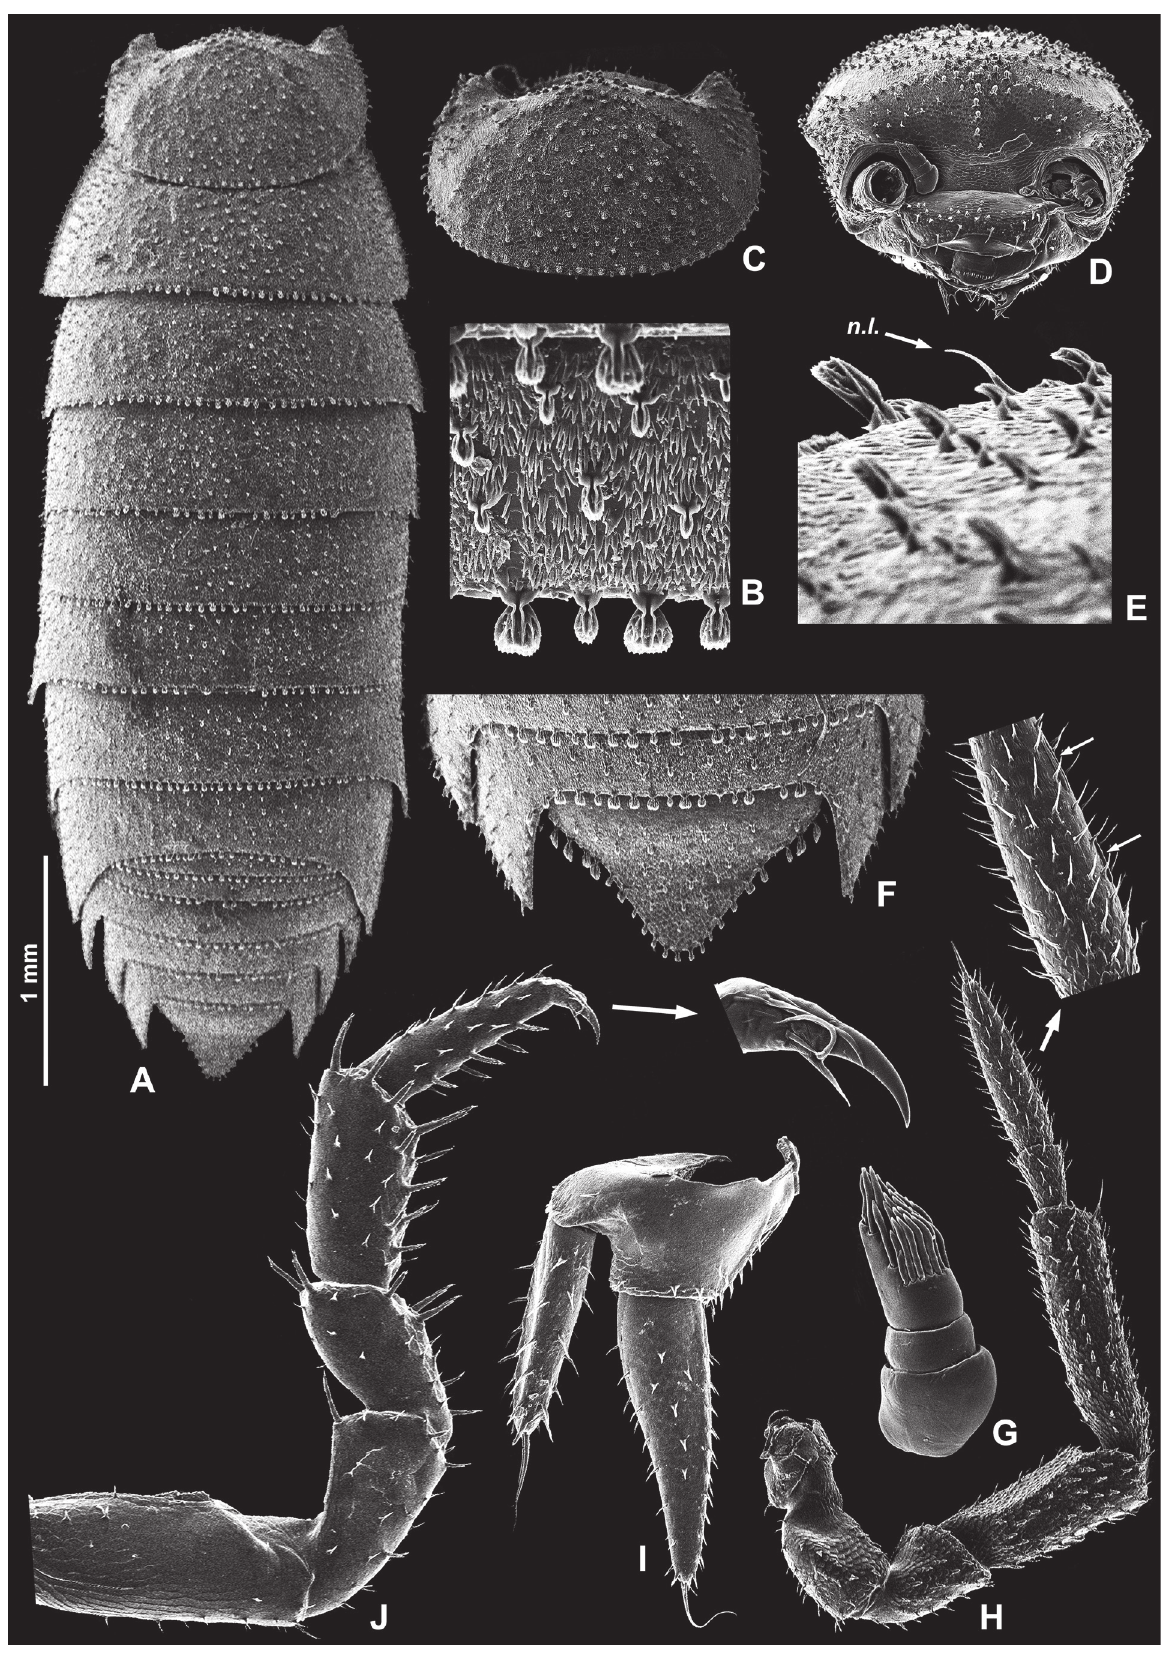
Figure 8. Trichorhina cipoensis n. sp. (male paratype). A, habitus, dorsal view; B, dorsum and scale-setae; C, cephalon, dorsal view; D, cephalon, frontal view; E, dorsum surface, scale-setae and nodulus lateralis ; F, pleonites 4 and 5, and telson; G, antennula; H, antenna; I, uropod; J, pereopod